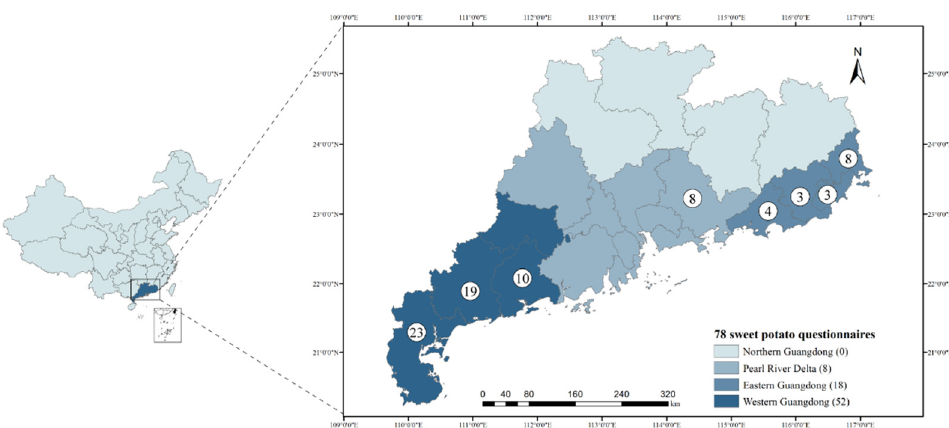
Figure 1. Distribution of sample sites for the face-to-face questionnaire survey during 2019 in Guangdong. The number is expressed as the sample size of the questionnaire.